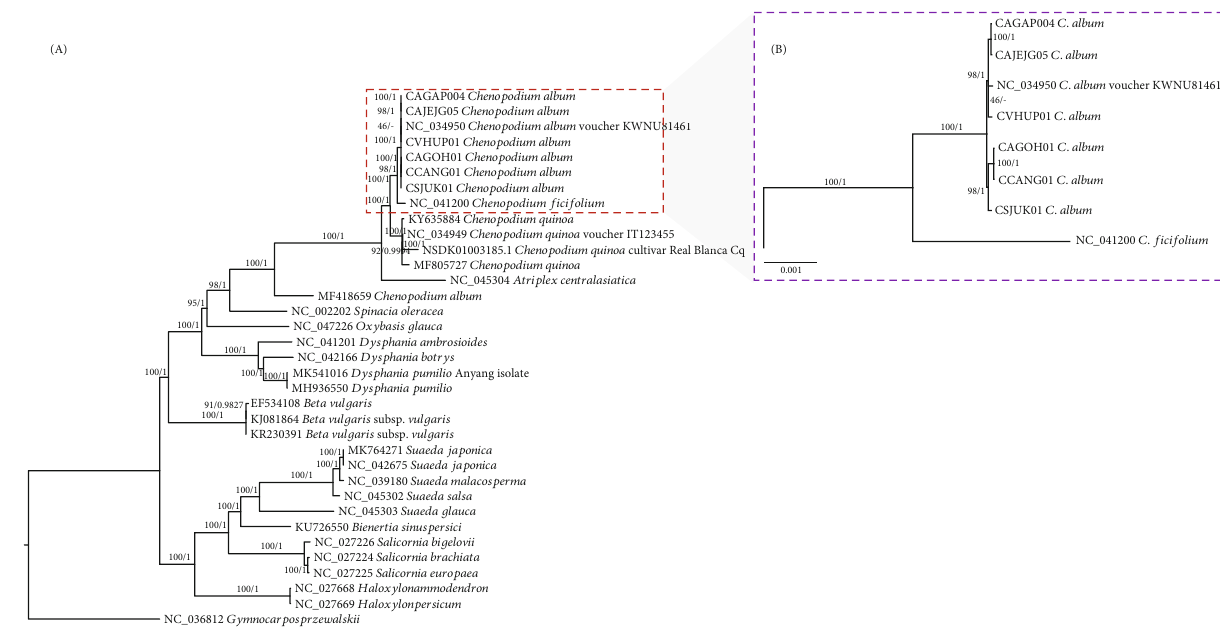
Figure 5: Phylogenetic trees of 34 Amaranthaceae chloroplast genomes. (a) Maximum likelihood (ML) and Bayesian inference (BI) phylogenetic trees were constructed based on complete chloroplast genomes of 34 Amaranthaceae species and Gymnocarpos przewalskii as an outgroup species. The phylogenetic tree was drawn based on the ML tree. Numbers on branches in the phylogenetic tree indicate bootstrap values of ML and prior possibility of BI, respectively. The dotted red rectangle indicates the clade covering C. album and C. fi cifolium . Chloroplast genomes sequenced in this study were presented as bold characters. (b) Partially enlarged phylogenetic tree of the clade of C. album and C. fi cifolium was displayed. Numbers on branches in the phylogenetic tree indicate bootstrap values of ML and prior possibility of BI, respectively. Chloroplast genomes sequenced in this study were presented as bold